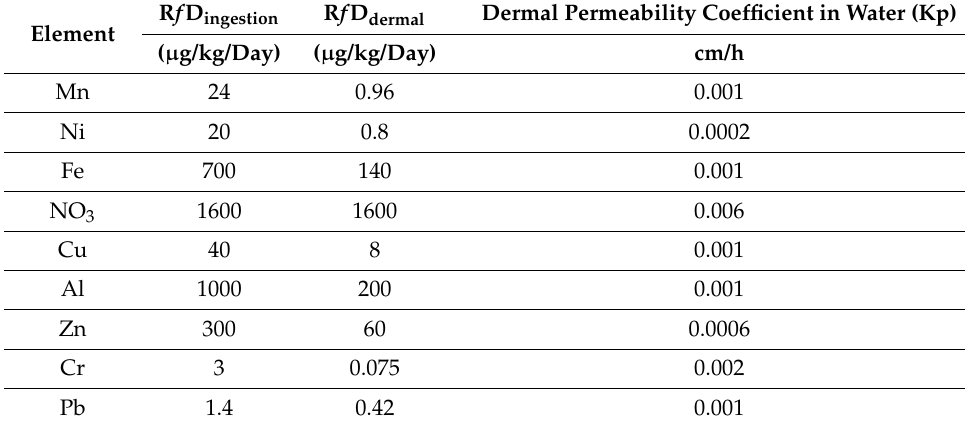
Table 3. Standard dose and guideline values